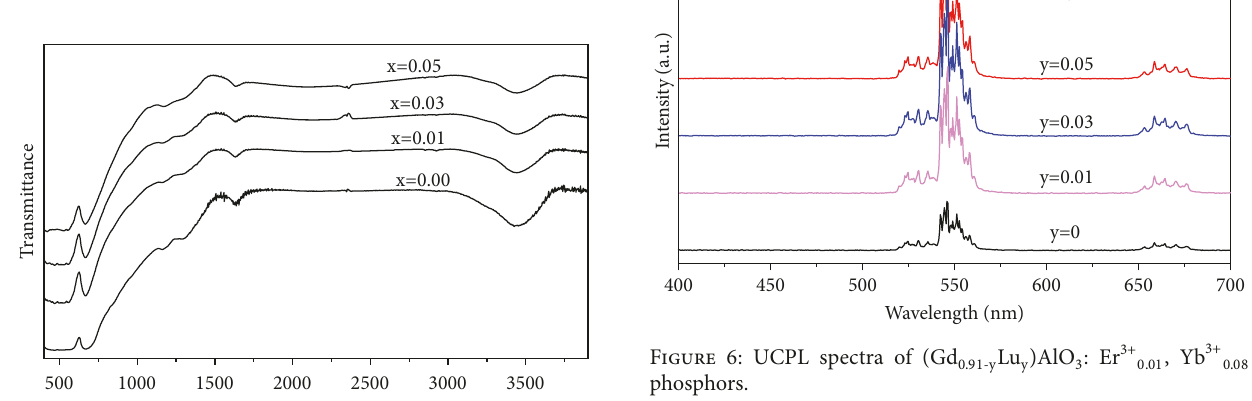
Figure 3: UCPL intensity of Gd(Al 1 phosphors at 546nm (inset is the intensity ratio of red/green emission on Ga 3+ concentration).